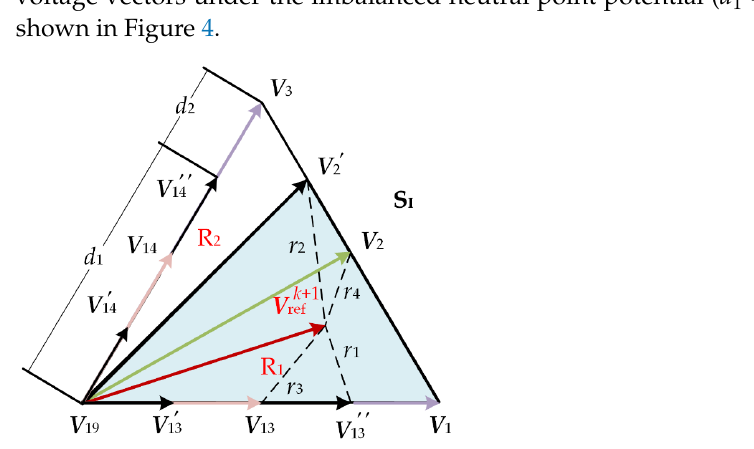
Figure 4. Medium and small vectors for d 1 = 0.5 and d 2 =